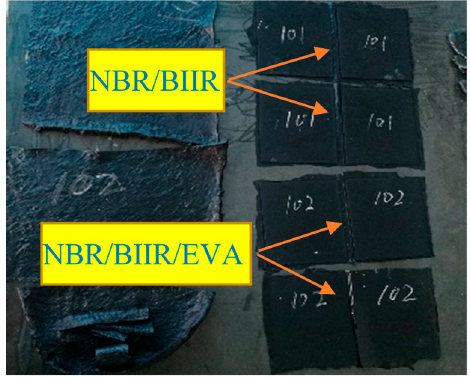
Figure 2. Test Figure 2. Test samples.